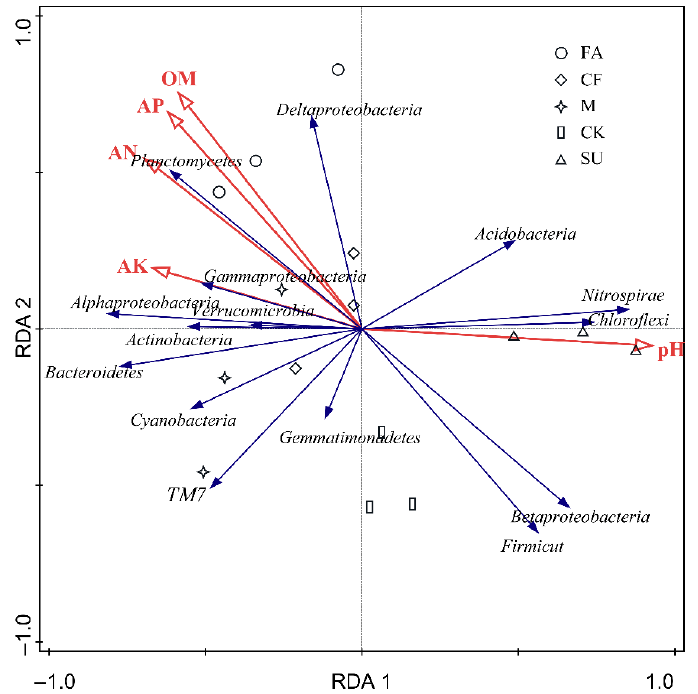
Figure 4. Redundancy analysis (RDA) of abundant phyla ( proteobacterial classes) and selected soil edaphic properties such as pH, SOM, AN, AP, and AK for individual samples from three sites. SOM: organic matter; AN: alkali-hydrolyzable nitrogen; AP: available phosphorus; AK: available potassium; CK: reclaimed soil sampled in no-fertilizer treatment; CF: reclaimed soil sampled in chemical fertilizer treatment; M: reclaimed soil sampled in manure treatment. SU: subsided soil sampled in an adjacent site; FA: soil sampled in another adjacent farmland. TM7: t he phylum candidatus Saccharibacteria . The red arrow: soil property factors; The blue arrow: the main group of bacteria phyla.